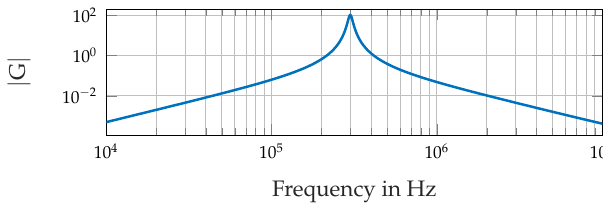
Figure 11. Filter- and Amplifier-circuit used for each receiver coil.